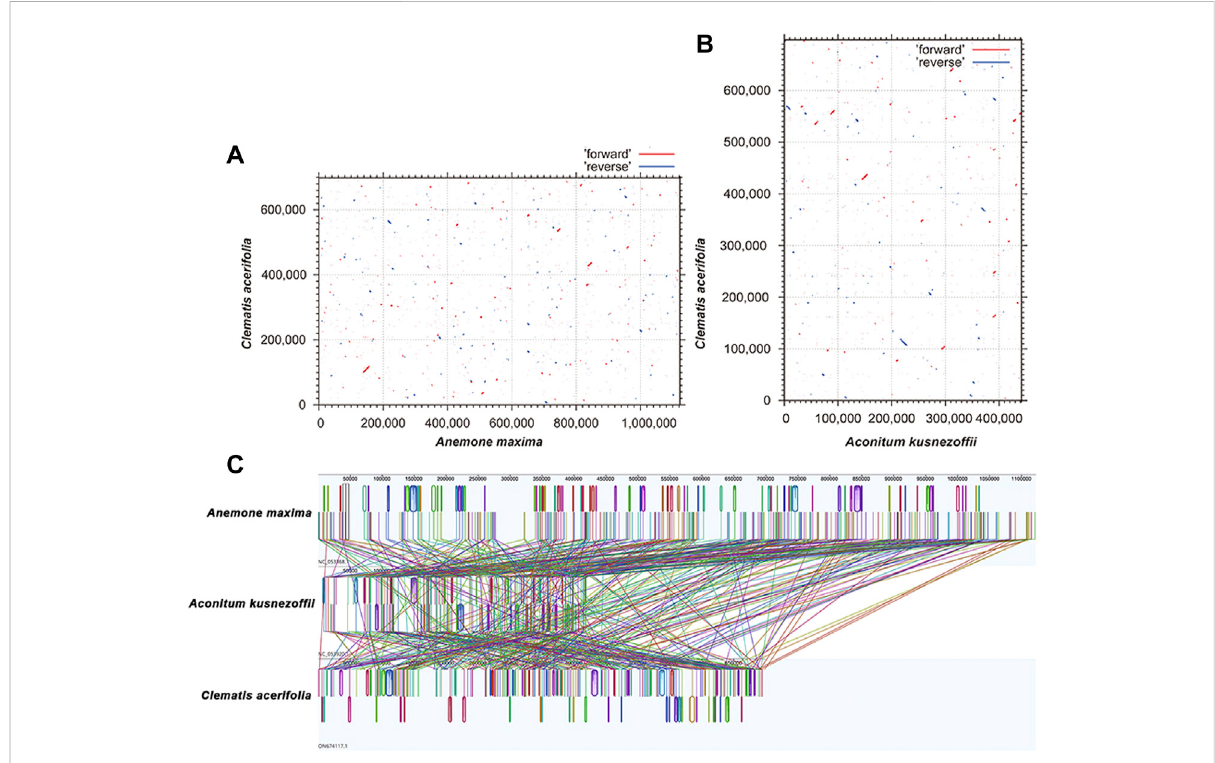
FIGURE 9 Dot plot and collinearity analysis of the mitogenomes of C. acerifolia , A. maxima and A. kusnezof fi i . (A, B) are dot plots of A. maxima and A. kusnezof fi i with C. acerifolia , respectively. (C) is the collinearity analysis between mitogenomes, with homologous regions represented by the same color blocks and connected by